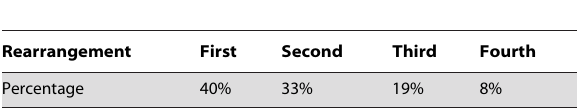
Table 4. Contribution of each rearrangement round into the total V-J combinatorial repertoire.